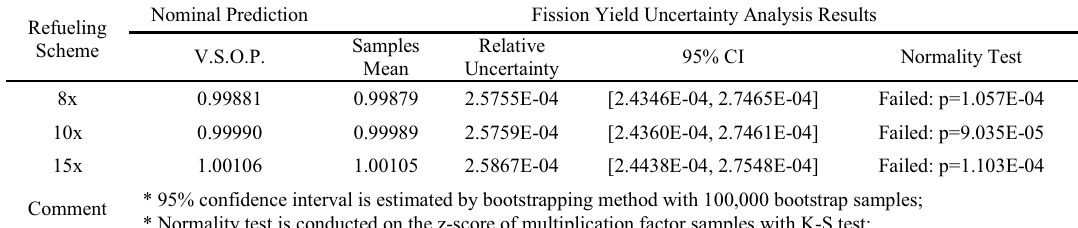
Table III. Multiplication Factor Uncertainty Analysis